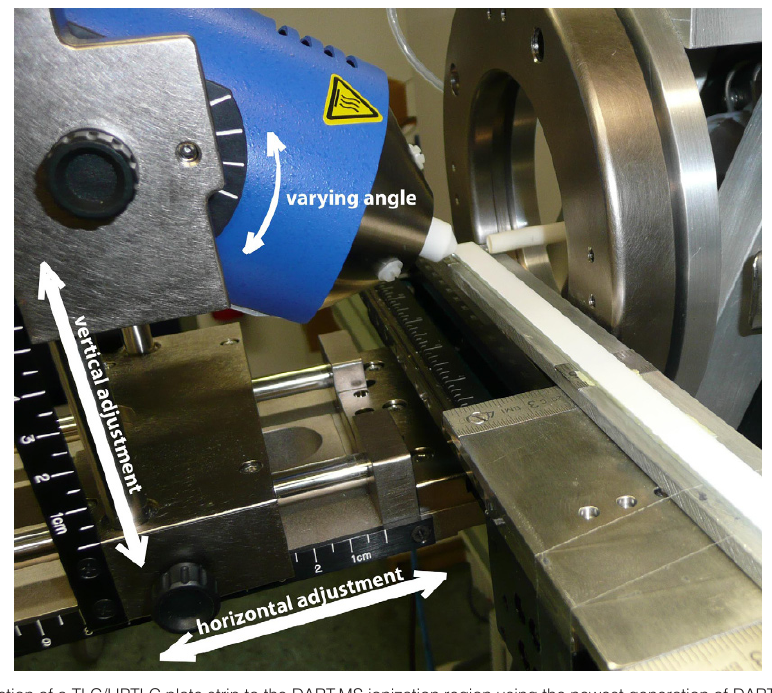
Figure 2. Introduction of a TLC/HPTLC plate strip to the DART-MS ionization region using the newest generation of DART ion source models with the desorption at an angle option and a self-built x -table, providing scanning analysis of surfaces (reproduced from [20], with permission of ‘John Wiley and Sons’).